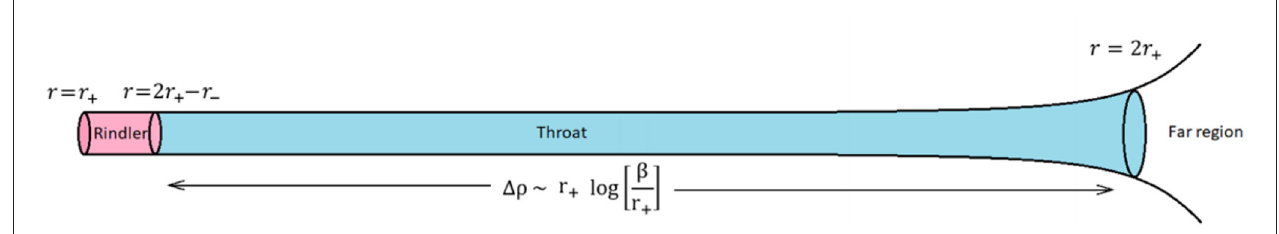
FIGURE 1 | The three regions outside a near-extremal charged black hole. Unlike for uncharged black holes, there is now a “throat” separating the Rindler and far regions.